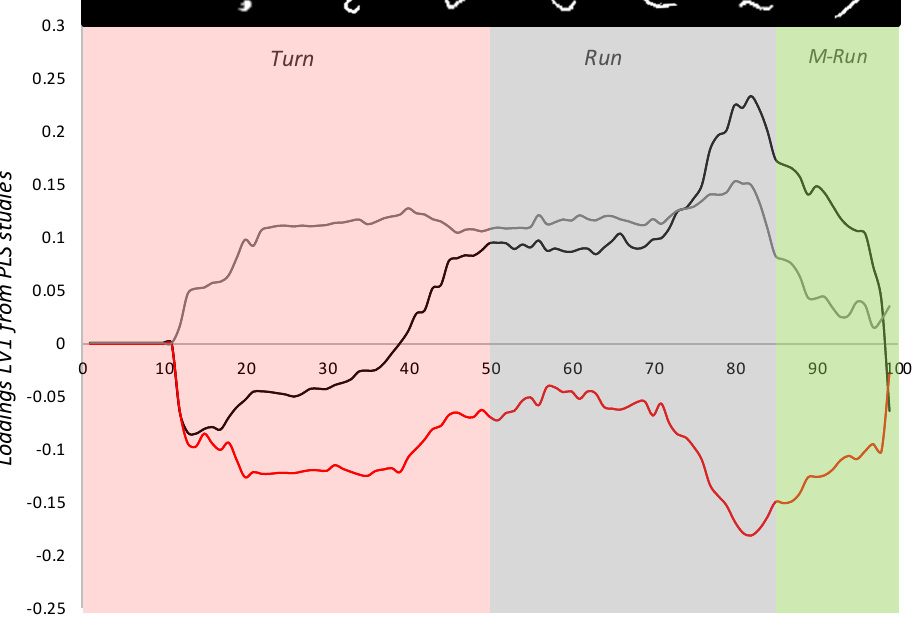
Figure 7. Loadings from latent variable 1 ( LV1 ) of mortality, M , and A m . Lines show the load of variance from each zone of the postural spectra in the explanation of the calibration coefficients: M : black line; A m : gray line; mortality: red line. Divisions of the % worm length axis indicate the zones of the postural spectra corresponding to turn (red), run (black), and M-run (green). The legends show the % of each zone during tracking.